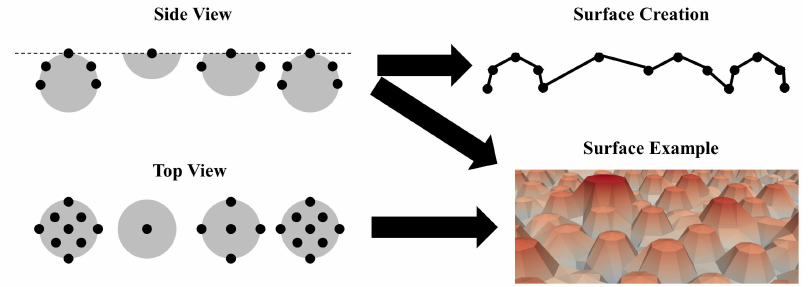
Figure 14. Visualisation of simulated grinding wheel surface.